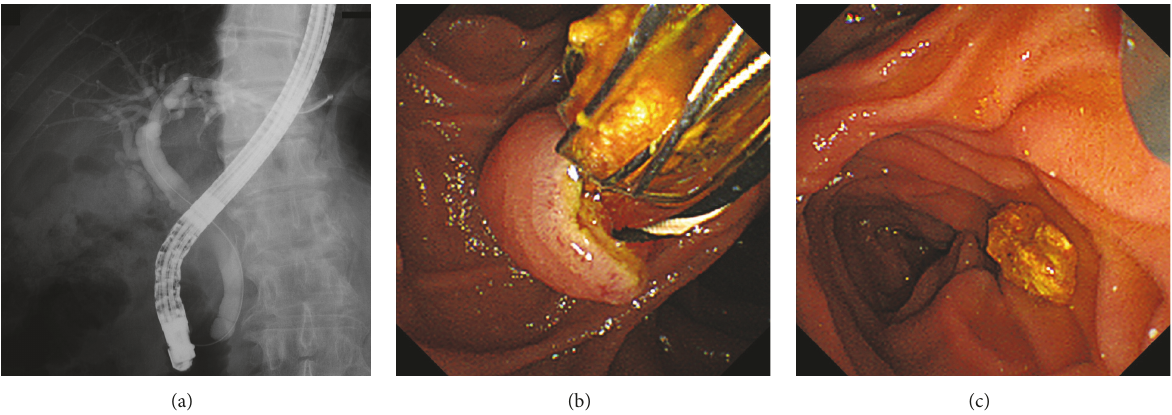
Figure 3: Endoscopic retrograde cholangiography images. Cholangiogram revealed no fistulas or anomalies (a). Small stones were endoscopically retrieved from the common bile duct (b,